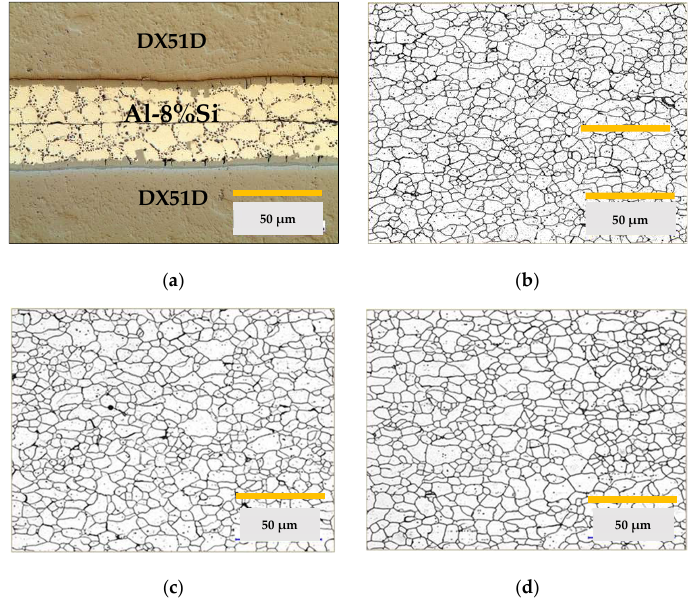
Figure 5. Metallographic images of DX51D steel, ( a ) detail of Al-Si coating in a set-up of sheets; ( b ) microstructure in supply state; ( c ) microstructure after thermal cycle 1; ( d ) microstructure after thermal cycle 2.